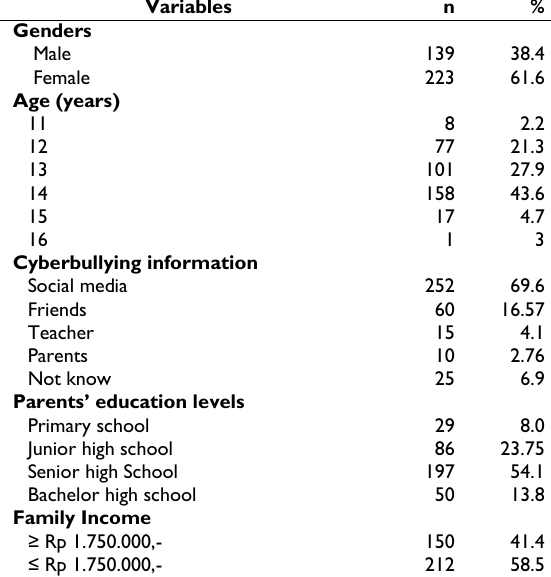
Table 1 Demographic characteristics of the respondents (N = 362)